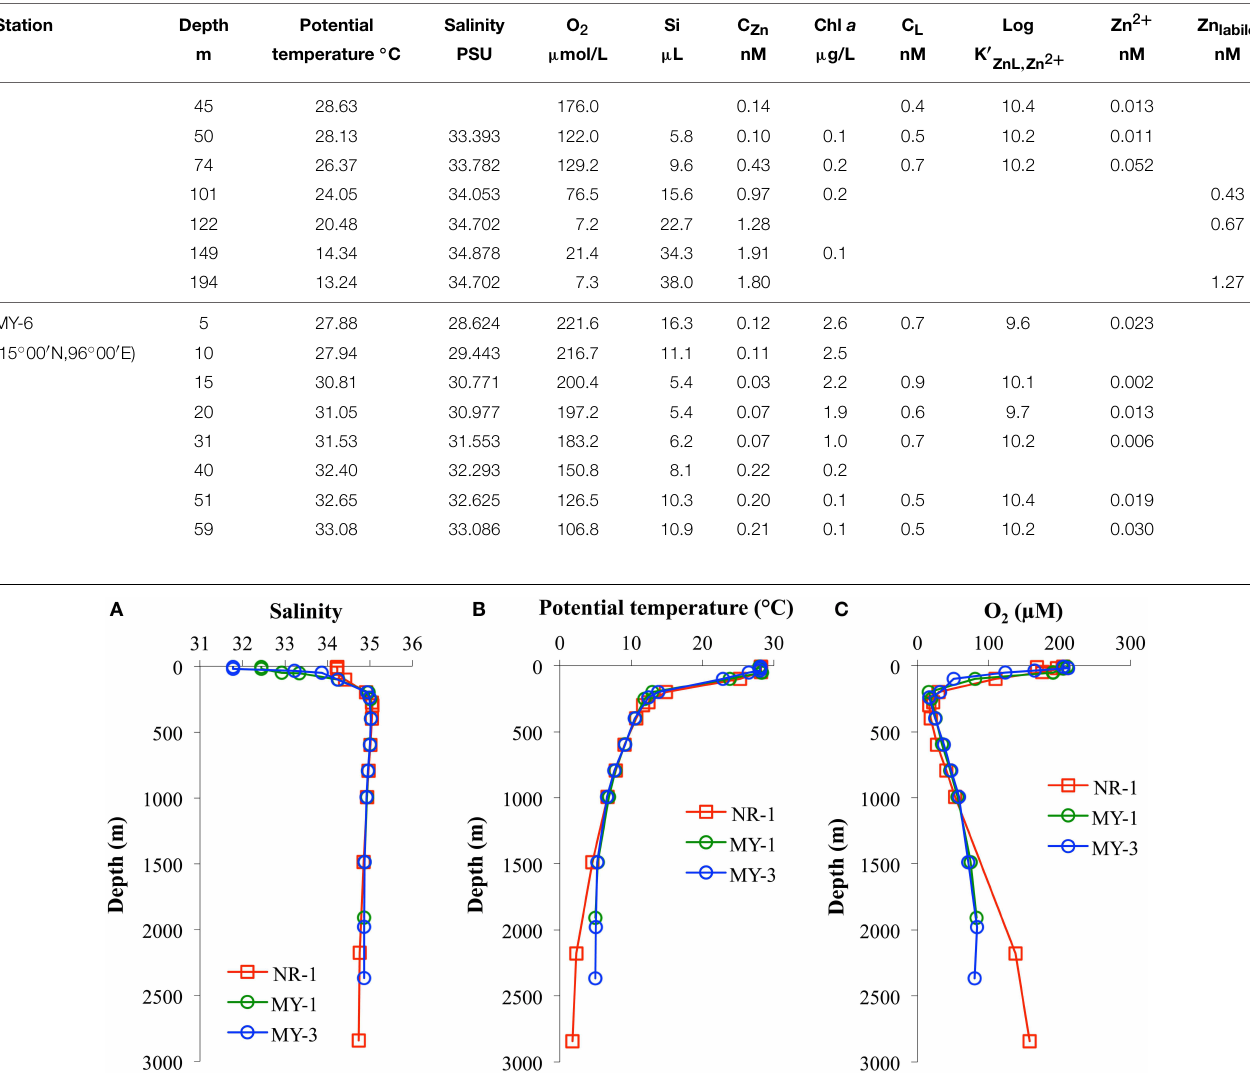
the contrary, the highest Si concentration in the near surface water, 16.3 µ M, was at the northernmost station of the Andaman Salween